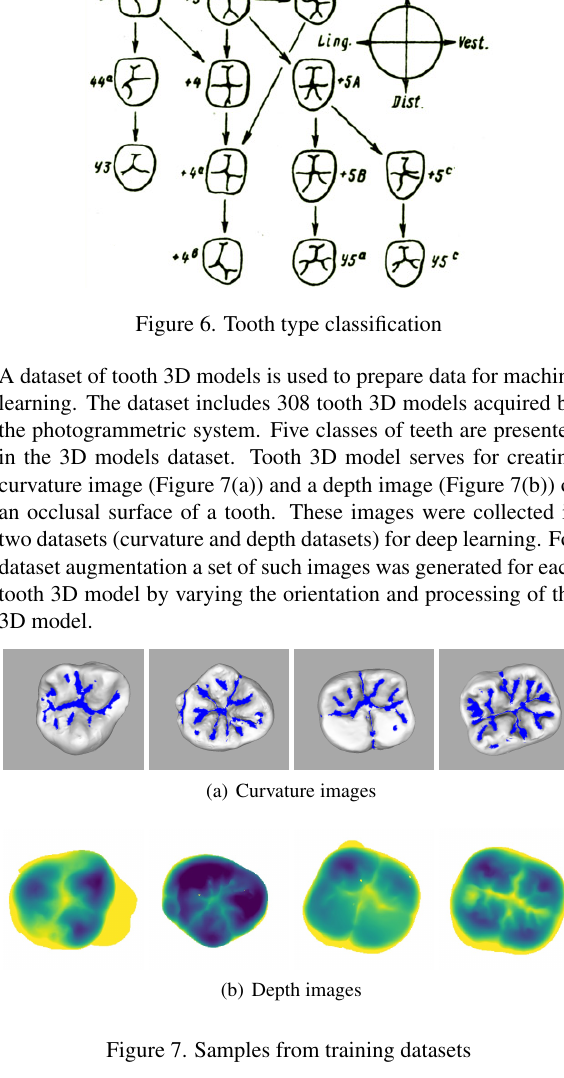
Table 2. Comparison of manual an automated measurements